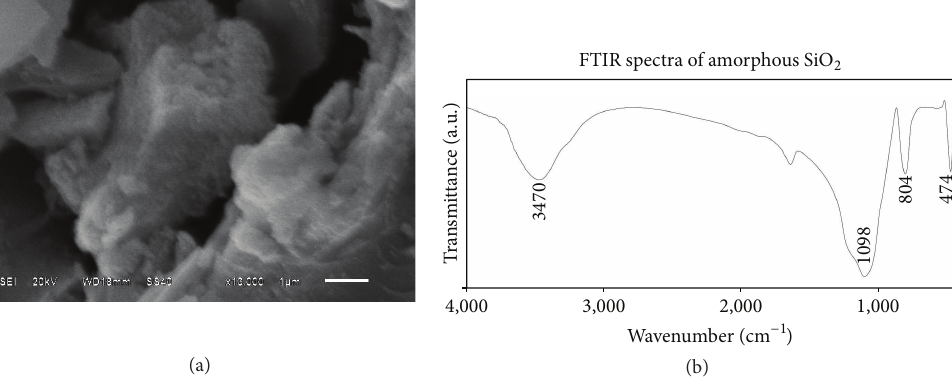
Figure 2: (a) SEM image of amorphous silica and (b) its corresponding FTIR spectra peaks.